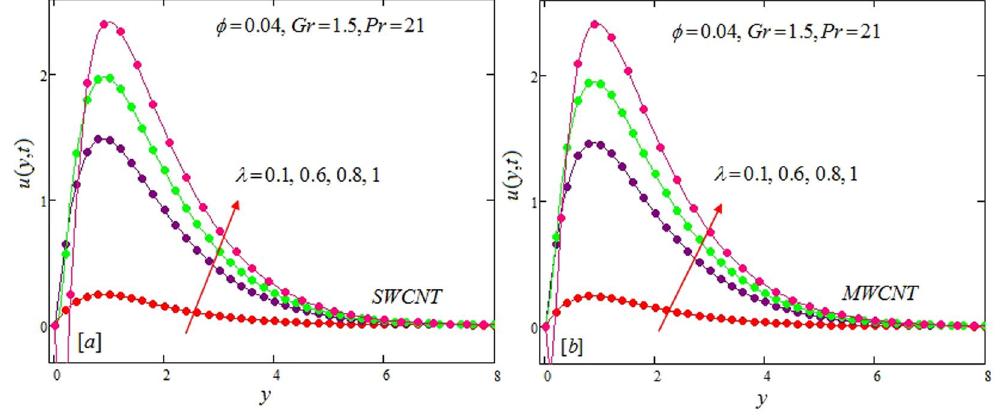
Figure 6. Velocity profiles for single and multiple wall CNTs for different values of Maxwell parameter.